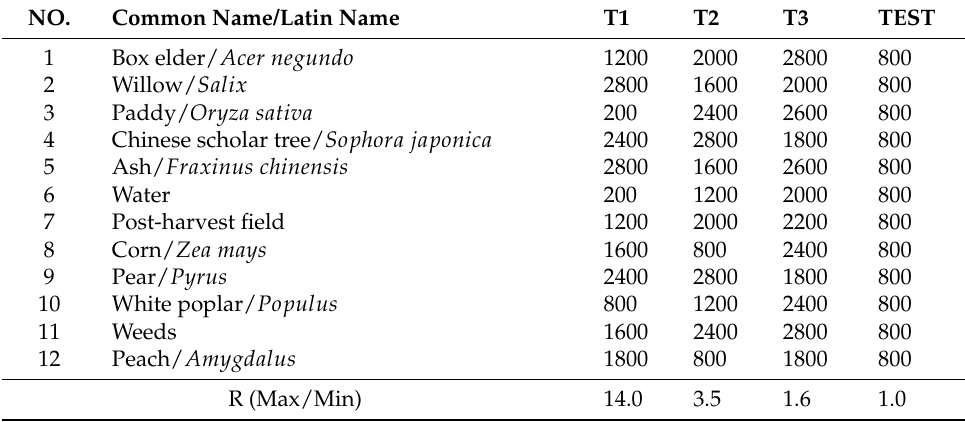
Table 1. Labeled samples of